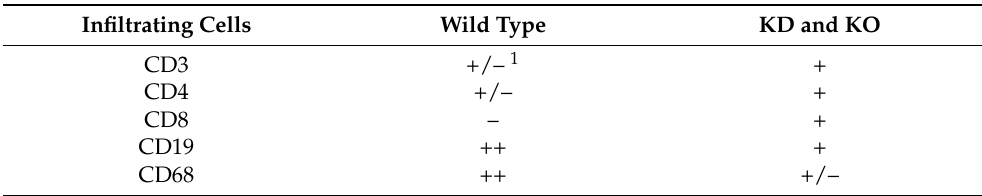
Table 3. Abundance of infiltrating immune cell subsets in tongues isolated from wild-type, PI3K γ KD/KD (KD) and PI3K γ − / − (KO) mice. Infiltrating Cells Wild Type KD and KO CD3 +/– 1 + CD4 +/– + CD8 –